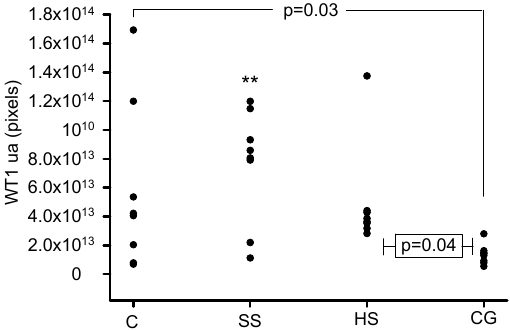
Figure 7. Densitometric analysis of the glomerulus for the ripening marker WT1 in the experimental